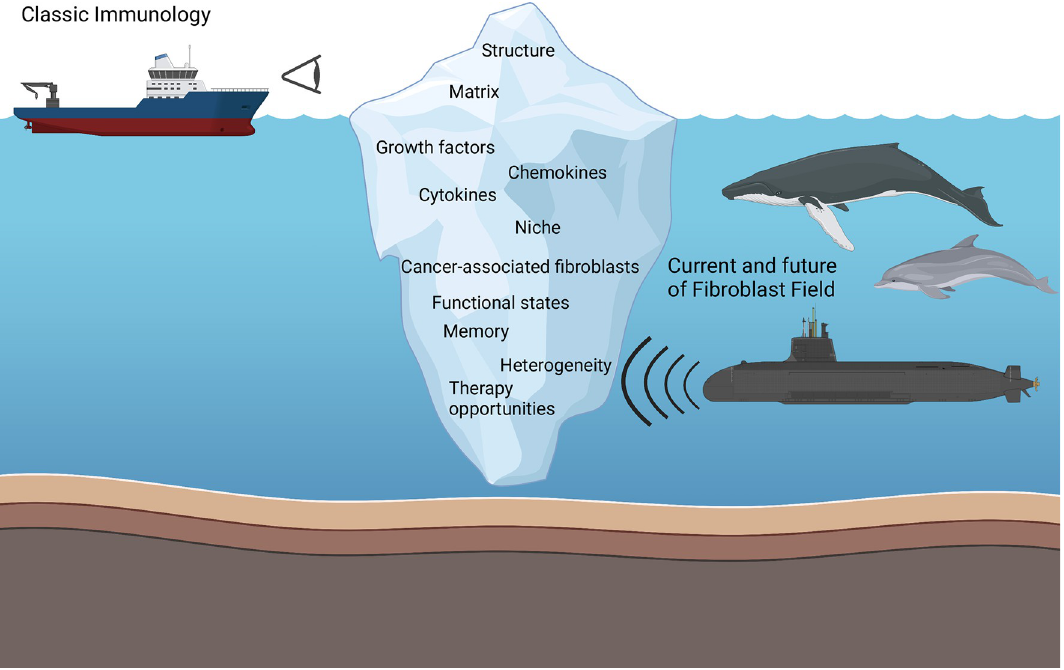
Fig 1. The past, present, and future of fibroblasts. Classical immunology generally views fibroblasts as the cells that provide structure and stiffness to tissues. In fact, that is only the tip of an iceberg and now that technologies have advanced (represented by the